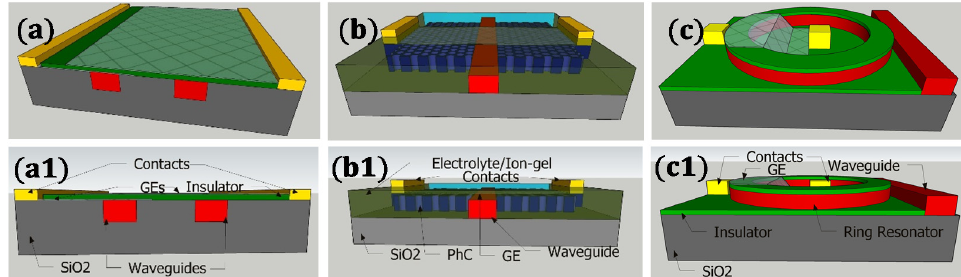
Figure 7. Examples of the device configurations: ( a , a1 ) Mach–Zehnder graphene modulator (M- ZM), ( b , b1 ) planar photonic crystal nanocavity-based modulator (CNM) and ( c , c1 )–micro-ring resonator (MRR).